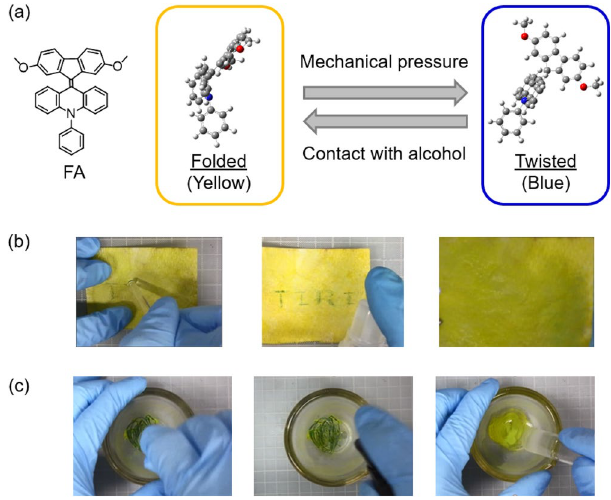
Figure 1. ( a ) Molecular structure of FA and ground-state mechanochromism. ( b ) Resetting the mechanochromism using ethanol. ( c ) Prevention of mechanochromism in the presence of ethanol.